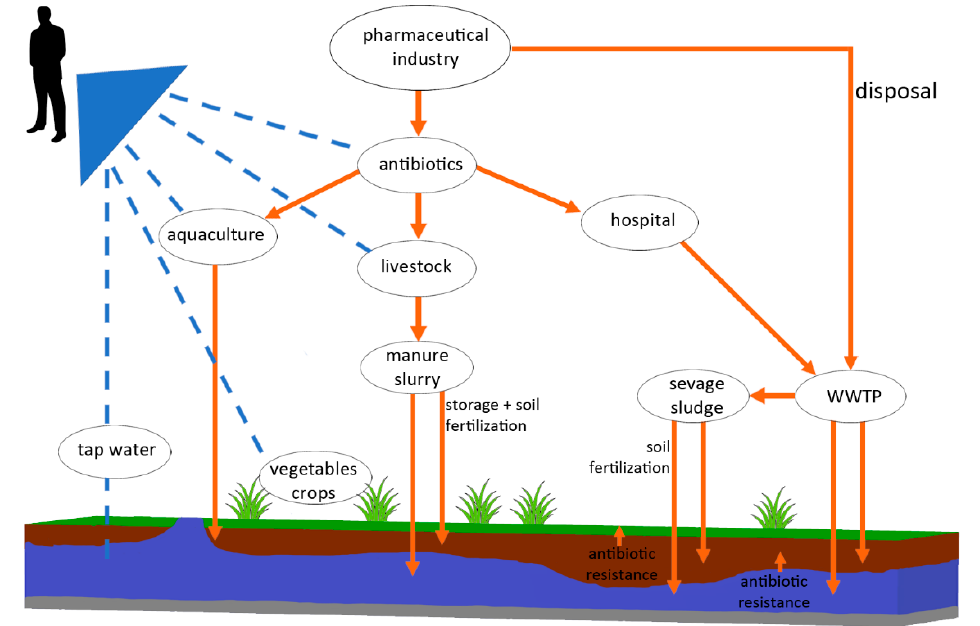
Figure 1. Release of antibiotic residues into the environment and human exposure to antimicrobials and antibiotic-resistant bacteria.